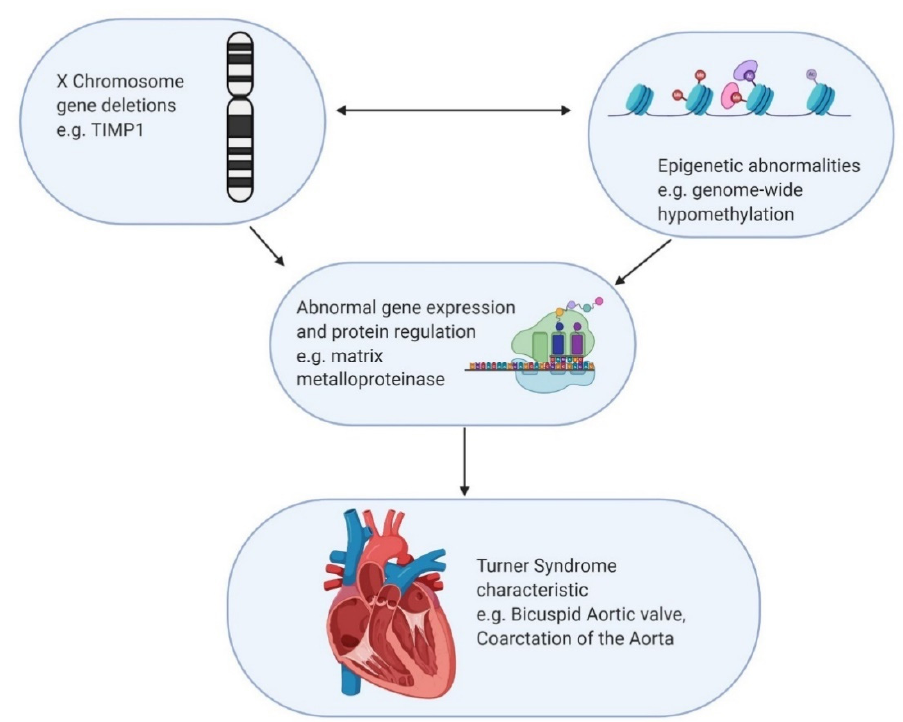
Figure 3. Hypothetical mechanism for interaction between genetic and epigenetic factors resulting in Turner manifestation. The example used involves loss of the TIMP1 gene interacting with genome wide hypomethylation with unclear causation, resulting in cardiovascular defect.